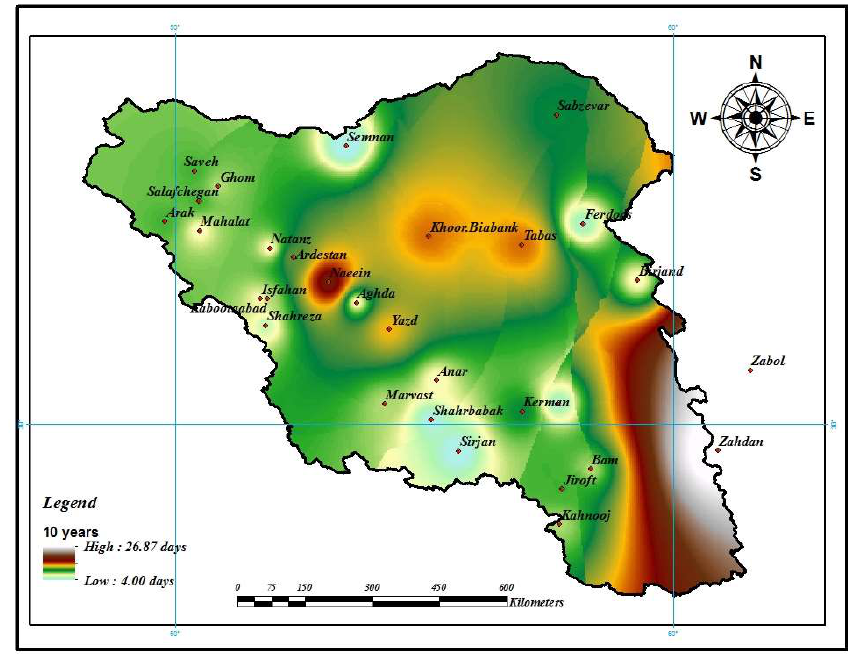
Figure 13. Dust day duration in the 10-year return period in the study area.